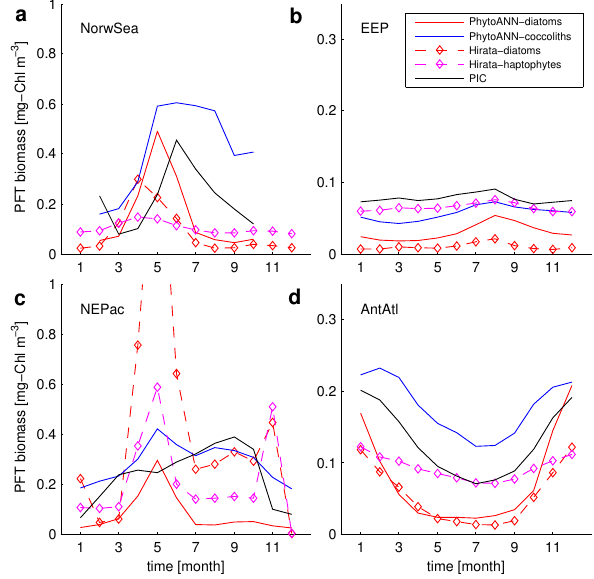
Fig. 8. 1997–2004 monthly climatology of diatom (red) and coccol- ithopore (blue) biomass from PhytoANN compared with diatoms and haptophytes (magenta) from the bio-optical algorithm as well as PIC from space (black) in four areas: (a) NorwSea, (b) EEP, (c) NEPac and (d) AntAtl. PhytoANN and PIC results are marked with a solid line, while the bio-optical algorithm with a dashed line. PIC values in molCm − 3 were multiplied by an arbitrary factor of 300 to match